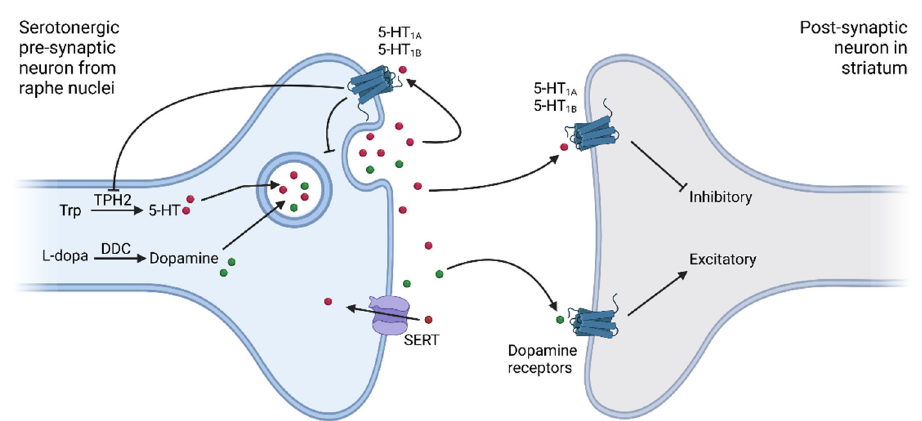
Figure 1. Synapse of the serotonergic pathway in the context of Parkinson’s disease pathogenesis. Dopaminergic neurons projecting from the substantia nigra to the striatum are degenerated in the process of Parkinson’s disease pathogenesis. Hence, serotonergic neurons originating in raphe nuclei take over the conversion of levodopa to dopamine. Serotonin is produced in these neurons as well. Both neurotransmitters are packaged into vesicles and released into the synaptic cleft via endocytosis. Both serotonin and dopamine then act on the postsynaptic neurons in the striatum. Serotonin has an inhibitory effect while dopamine acts in an excitatory manner. Serotonin is re-uptaken into the pre- synaptic neuron via the serotonin transporter. Simultaneously, the release of serotonin is also slowed down via the pre-synaptic serotonin receptors. Serotonergic pre-synaptic neurons do not possess the autoregulatory machinery to fine-tune the dopamine release. This means that the inhibiting feedback loop is lacking and dopamine is released from serotonergic neurons in an uncontrolled and unregulated